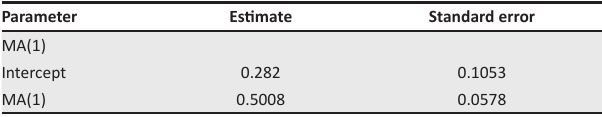
TABLE 2a: South Africa – Specification for the rate of change of exchange rate: A [MA(1)] model.